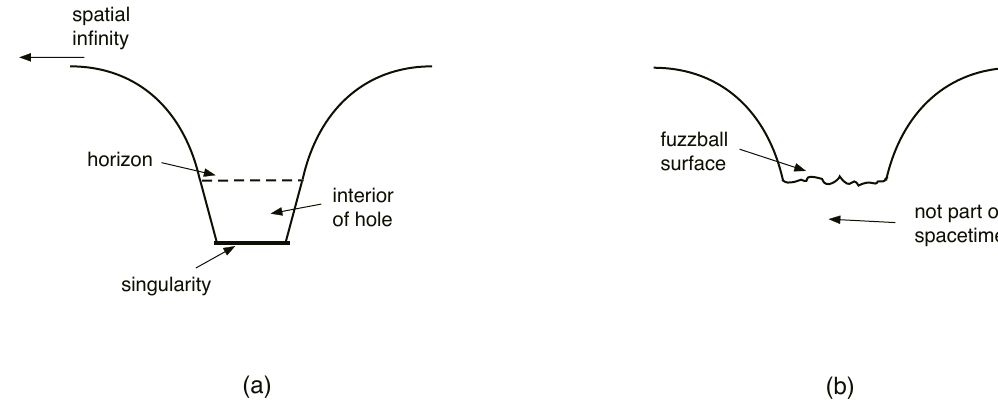
Figure 1 . (a) The conventional picture of a black hole. (b) the fuzzball picture: spacetime ends just outside the horizon in a quantum